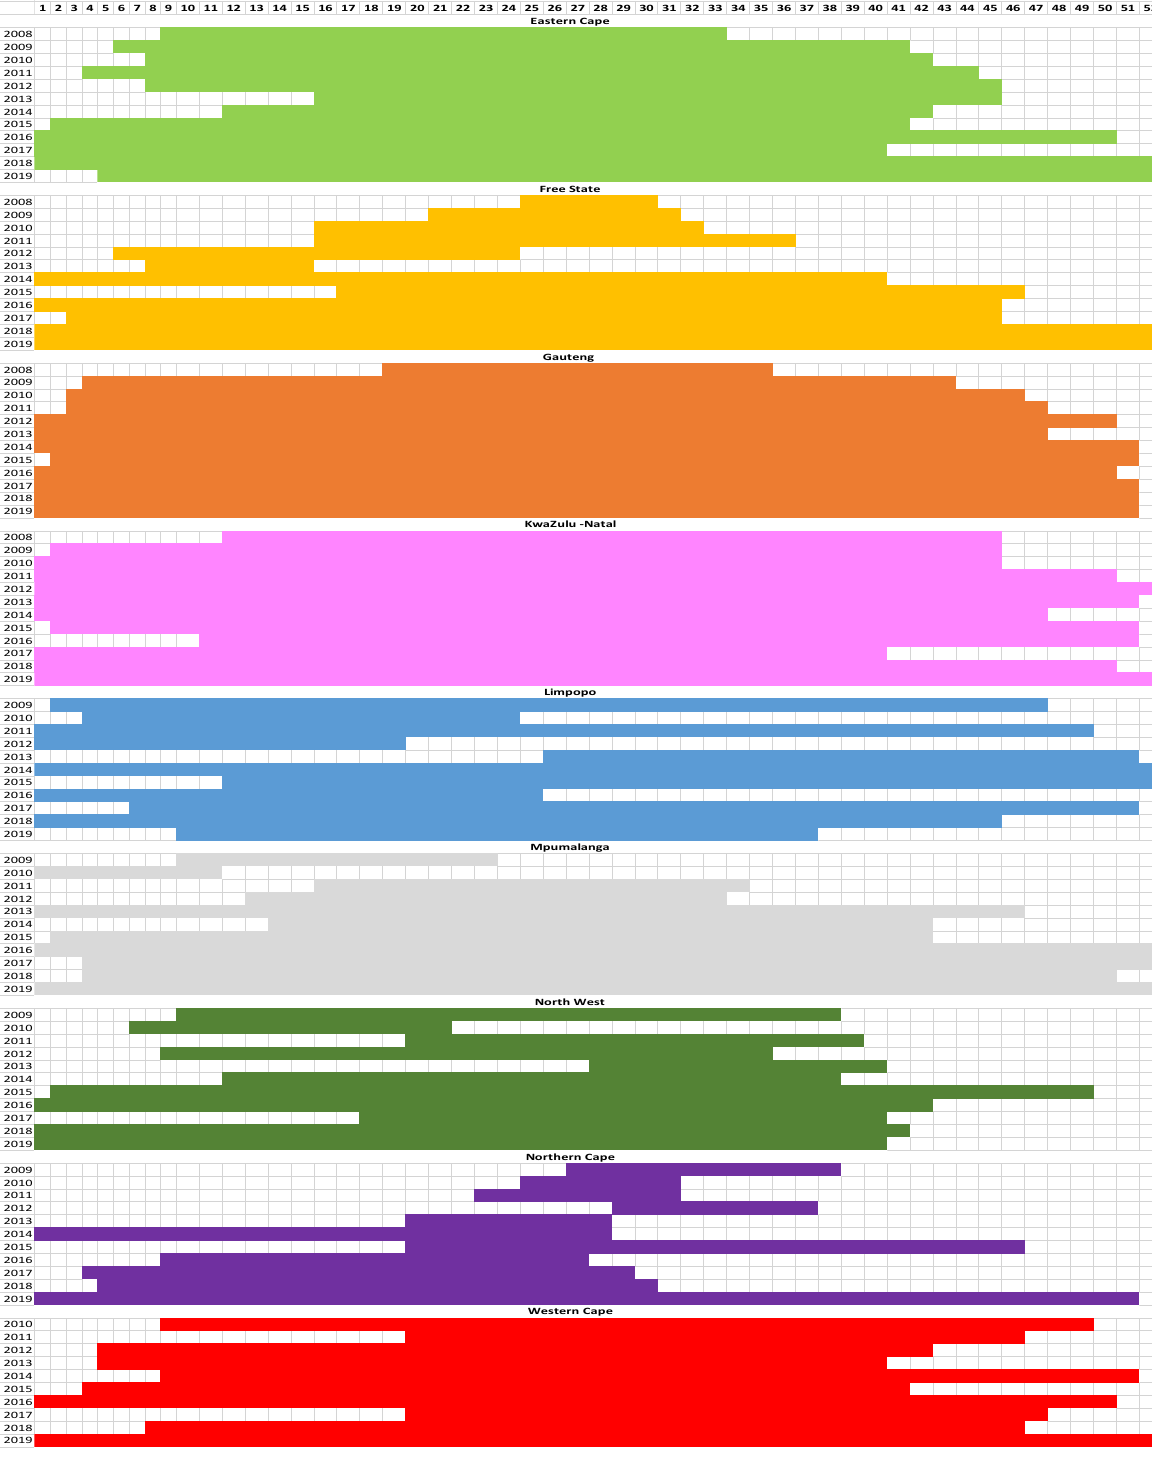
Figure 6. Applying Vega et al.’s [10] 5% threshold for South Africa’s nine provinces. After testing a series of different thresholds for each of the provinces, the most ap- propriate threshold was determined for each province, respectively, that yielded results that were close to a 19-week flu season from 2008 to 2019: Eastern Cape (17%), Free State (15%), Gauteng (20%), KwaZulu-Natal (25%), Limpopo (15%), Mpumalanga (15%), North West (13%), Northern Cape (11%), and Western Cape (18%) (Figure 7). The provinces had a distinct seasonal pattern. None of the provinces yielded precisely nineteen weeks, but the threshold selected for each province was close to the nineteen-week season proposed by the NICD. Gauteng, Western Cape, KwaZulu-Natal, and Eastern Cape had the most